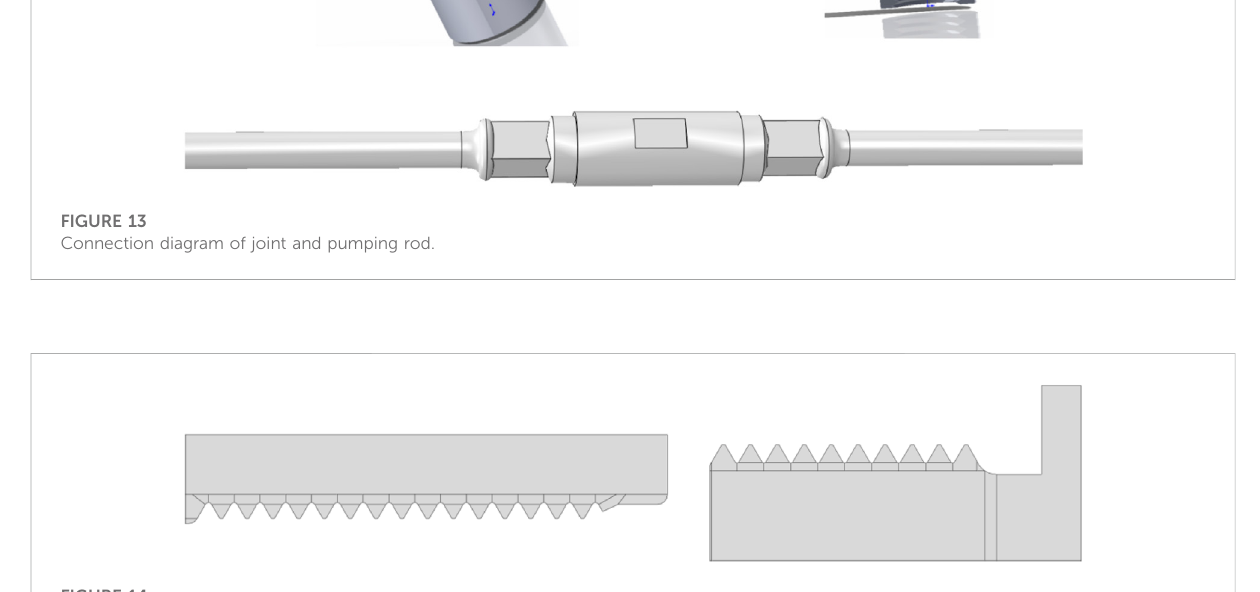
FIGURE 14 Cutting thread surface